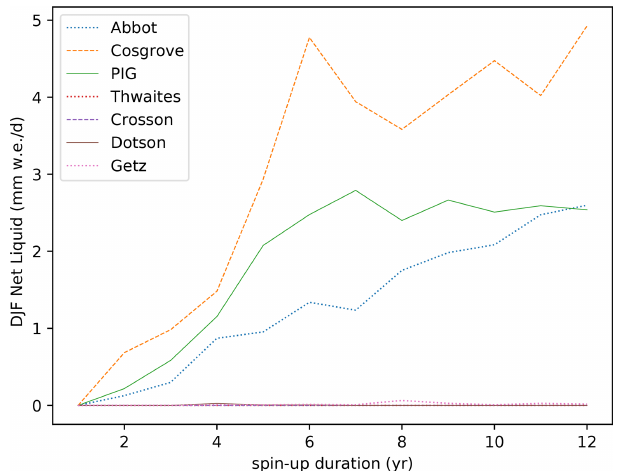
Figure 12. Net production of surface liquid water over individual ice shelves in DJF 1998 for various spin-up durations for Getz, Dot- son, Crosson, Thwaites, Pine Island Glacier (PIG), Cosgrove, and